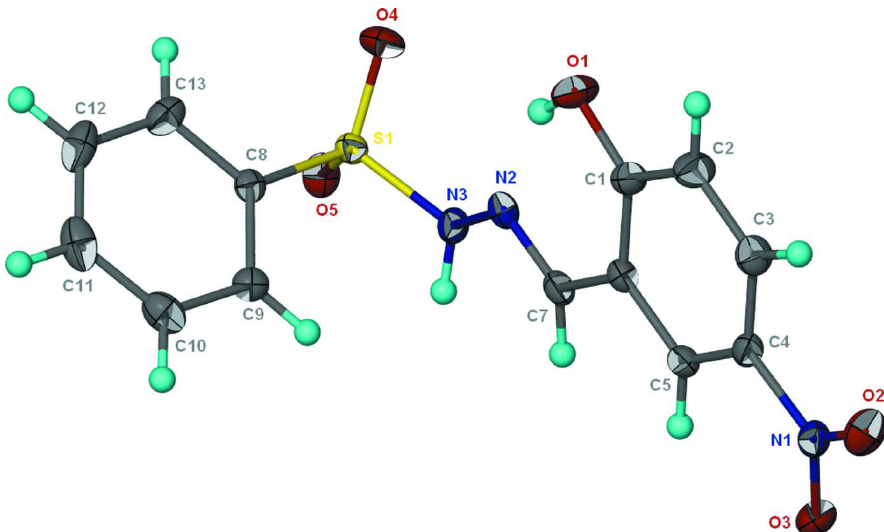
Figure 1 Thermal ellipsoid plot (Barbour, 2001) plot of C spheres of arbitrary radius.